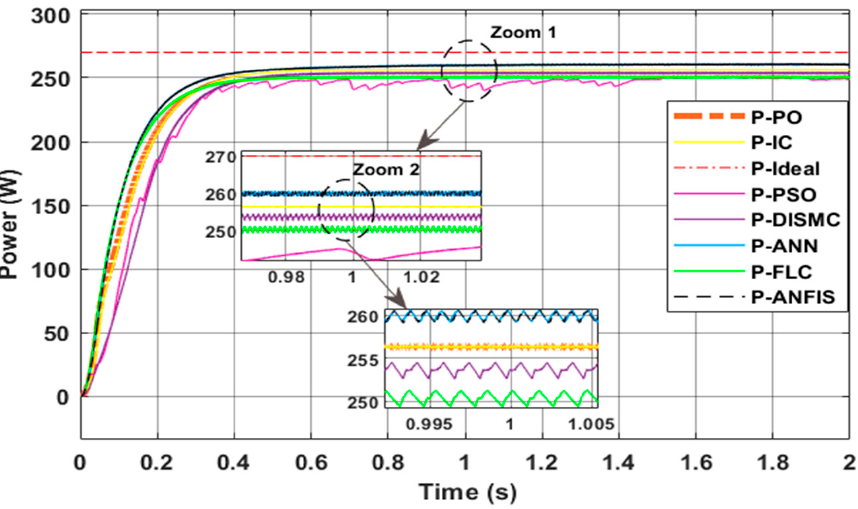
Figure 13. Evolution of power: Test 1.